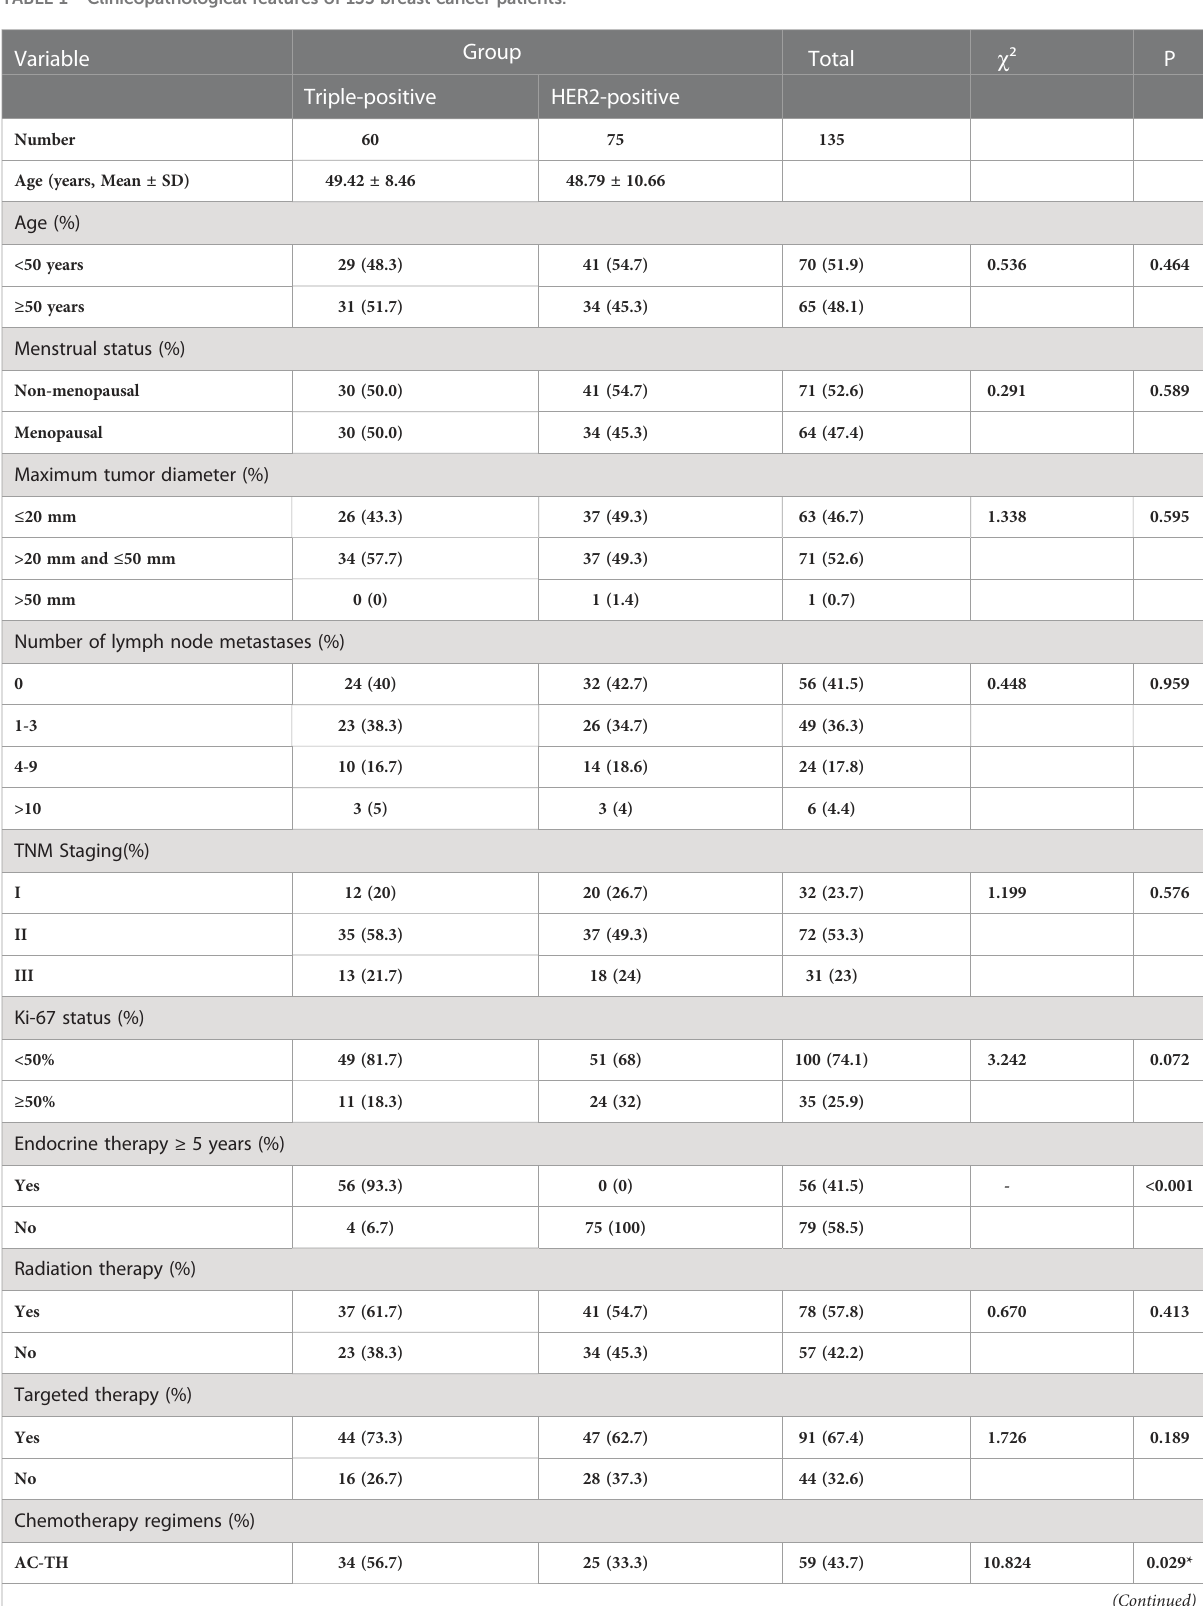
TABLE 1 Clinicopathological features of 135 breast cancer